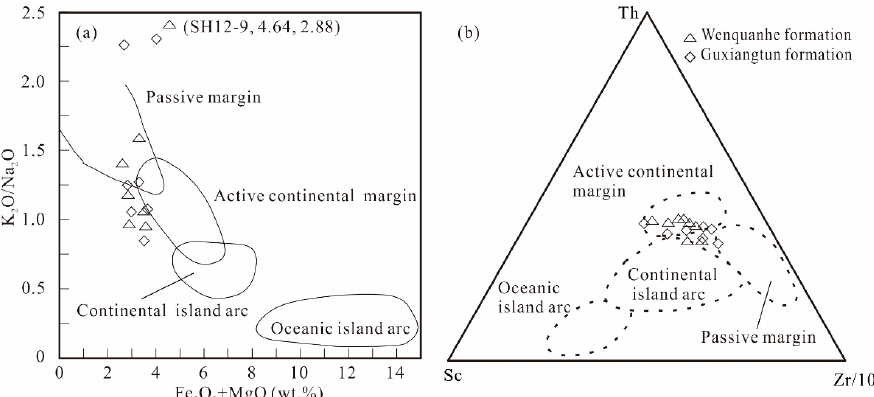
Figure 9. ( a ) Tectonic discrimination diagram of major elements for sandstones [38]. ( b ) Th–Cc– Zr/10 triangular discrimination plot [1].